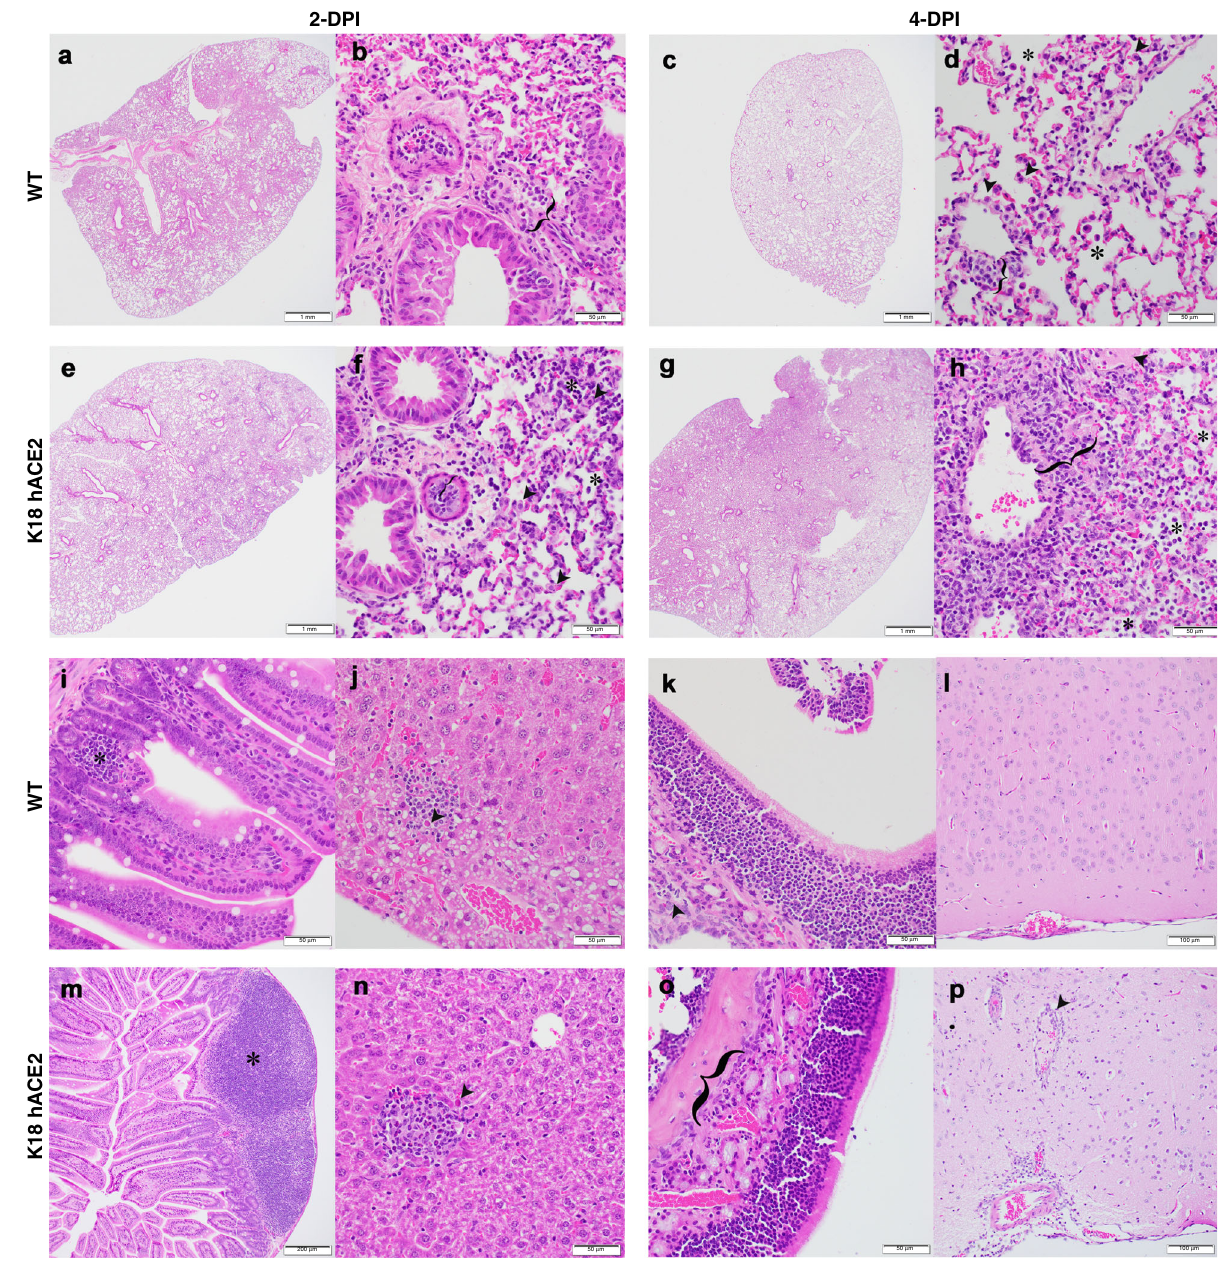
Fig. 5 K18 hACE2 transgenic mice develop rhinitis, pneumonia with associated pulmonary in fl ammation after infection with SARS-CoV-2. a – d and i – l WT C57BL/6 mice. Minimal mononuclear and neutrophilic interstitial pneumonia in WT lung at 2 DPI a , b bracket. By 4 DPI c , d minimal alveolar histiocytosis d , asterisk pneumocyte type II cells d , arrowheads, perivascular mononuclear in fl ammation d , bracket and rhinitis with low numbers of neutrophils k , arrowhead were variably observed. Lymphocyte aggregates in the lamina propria of the small intestine i , asterisk. Mixed mononuclear in fl ammation with individual hepatocellular necrosis j , arrowhead. Brain from WT 4 DPI was normal l . e – h and m – p K18 hACE2 transgenic mice. Interstitial pneumonia e , f associated with alveolar histiocytosis admixed neutrophils and lymphocytes f , asterisks, mild type II pneumocyte hyperplasia f , arrowhead, bronchiolar syncytia ( f , arrow), endothelial cells hyperplasia and vasculitis ( f , bracket) by 2 DPI. Gut-associated lymphoid tissue (GALT) with prominent germinal centers was observed ( m , asterisk). Liver in fl ammation with variable amounts of individual hepatocellular necrosis ( n , arrowhead). Greater lung involvement indicative of pneumonia ( g ), with in fl ammatory cellular accumulations and hemorrhage in alveolar spaces ( h , asterisk) and interstitium ( h , bracket), intra-alveolar fi brin admixed cellular debris ( h , arrow), vasculitis ( h , bracket), edema ( h , arrowhead) by 4 DPI. Neutrophilic rhinitis observed at 4 DPI ( o , bracket). Mild meningoencephalitis with vasculitis ( p , arrowhead). Representative images of n = 8 (50:50 male:female per time-point and group) randomly chosen. Scale bars left images, 1 mm. Scale bars right images, 50 μ m. DPI days post infection. Data are representative over two independent